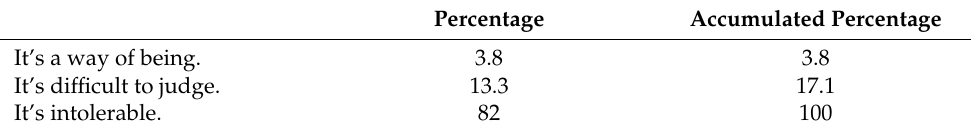
Table 3. Judgment distribution toward threats, crimes, and persecution through the Internet. Percentage Accumulated Percentage